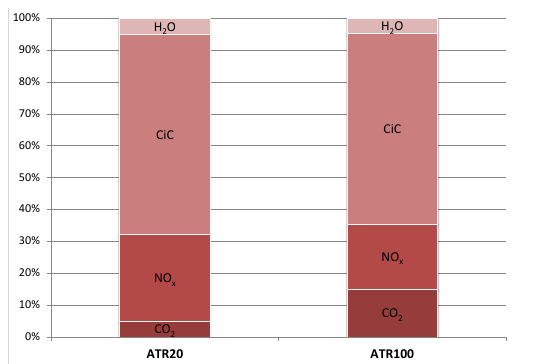
Figure 6. Environmental assessment of European traffic sample: relative contribution of individual climate impacts, CO 2 , NO x , contrail induced cloudiness (CiC), and H 2 O, to overall climate impact for ATR 20 and ATR 100 on 18 December